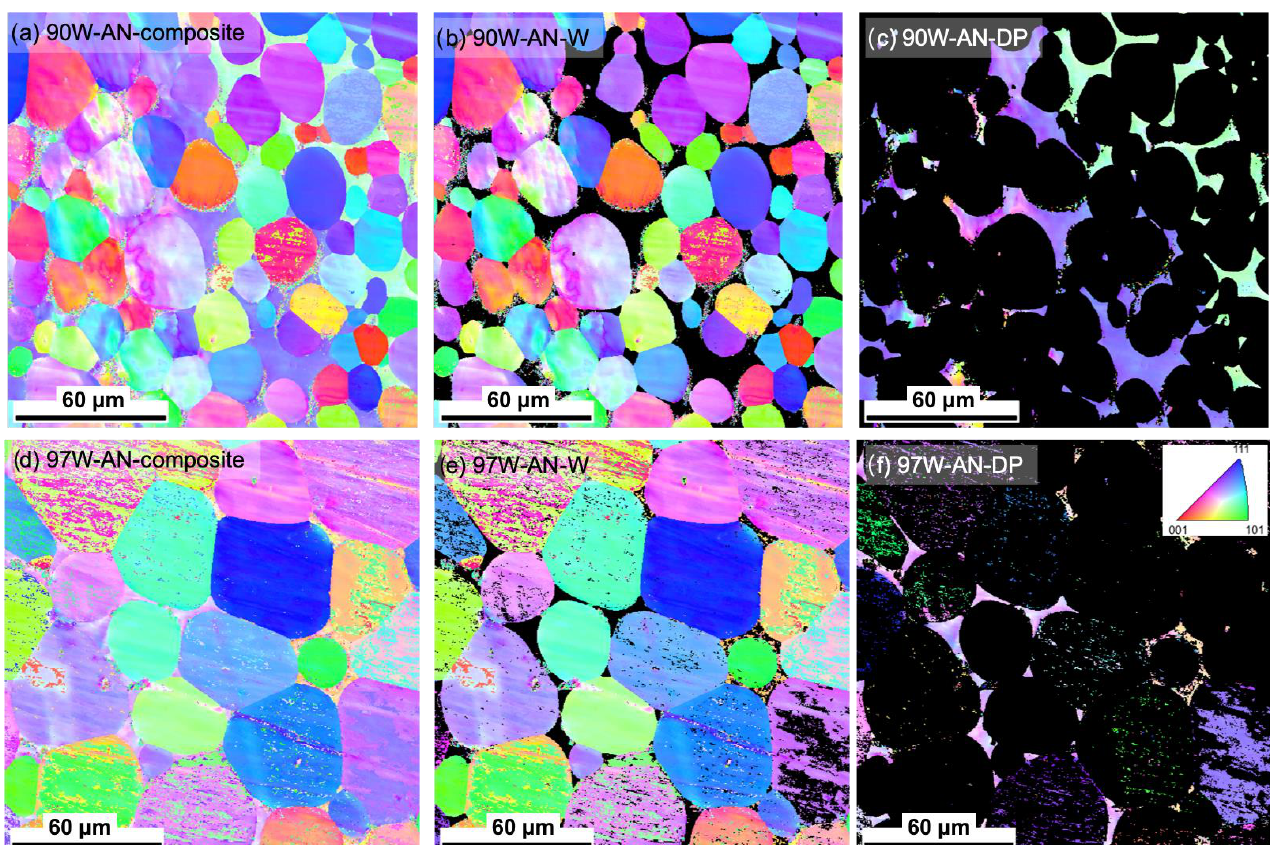
Figure 2. EBSD IPF map showing the random texture orientation for W and DP for 90W ( a – c ) and 97W ( d – f ) in the AN condition. Here, IPF maps are shown in the left column for the composites, the middle column for W, and the right column for DP for 90W (top row) and 97W (bottom row). The scale bars are all 60 µm. EBSD for the AS condition can be found in [33].